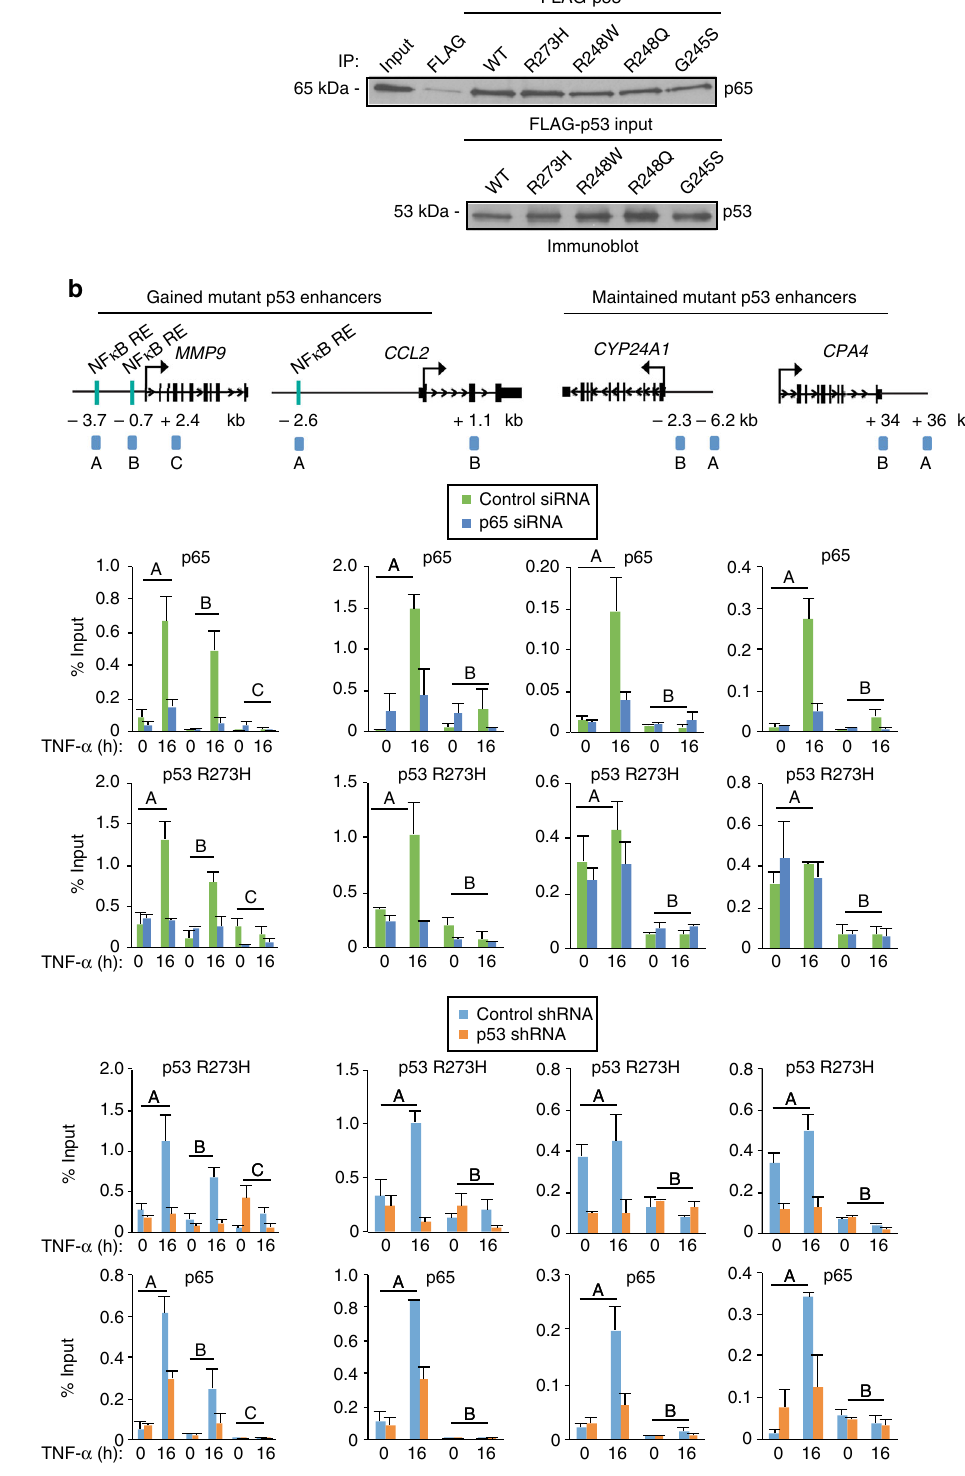
Fig. 3 Mutp53 and NF κ B interact and impact each other ’ s binding at enhancers. a Puri fi ed wild-type and mutp53 proteins bind directly to puri fi ed NF κ B/p65 as revealed by immunoblot analysis with an antibody that recognizes p65. Input samples for the p53 proteins were also analyzed by immunoblot analysis with an antibody that recognizes both wild-type and mutp53. Three independent interaction assays were performed. b ChIP-qPCR analyses of NF κ B/p65 and p53 R273H at the enhancer (A and B at MMP9 and A at CCL2 , CYP24A1 , and CPA4 ) or non-speci fi c (C at MMP9 and B at CCL2 , CYP24A1 , and CPA4 ) regions of the target gene loci in SW480 cells transfected with non-targeting control or p65 siRNA and following TNF- α treatment for 0 or 16 h. c ChIP-qPCR analyses of p53 R273H and NF κ B/p65 binding at identical genomic regions examined in ( b ). The SW480 cells were induced to express LacZ (control) or p53 (p53) shRNA and treated with TNF- α for 0 or 16 h. For both ChIP experiments, an average of two independent experiments that are representative of at least three is shown with error bars denoting the standard